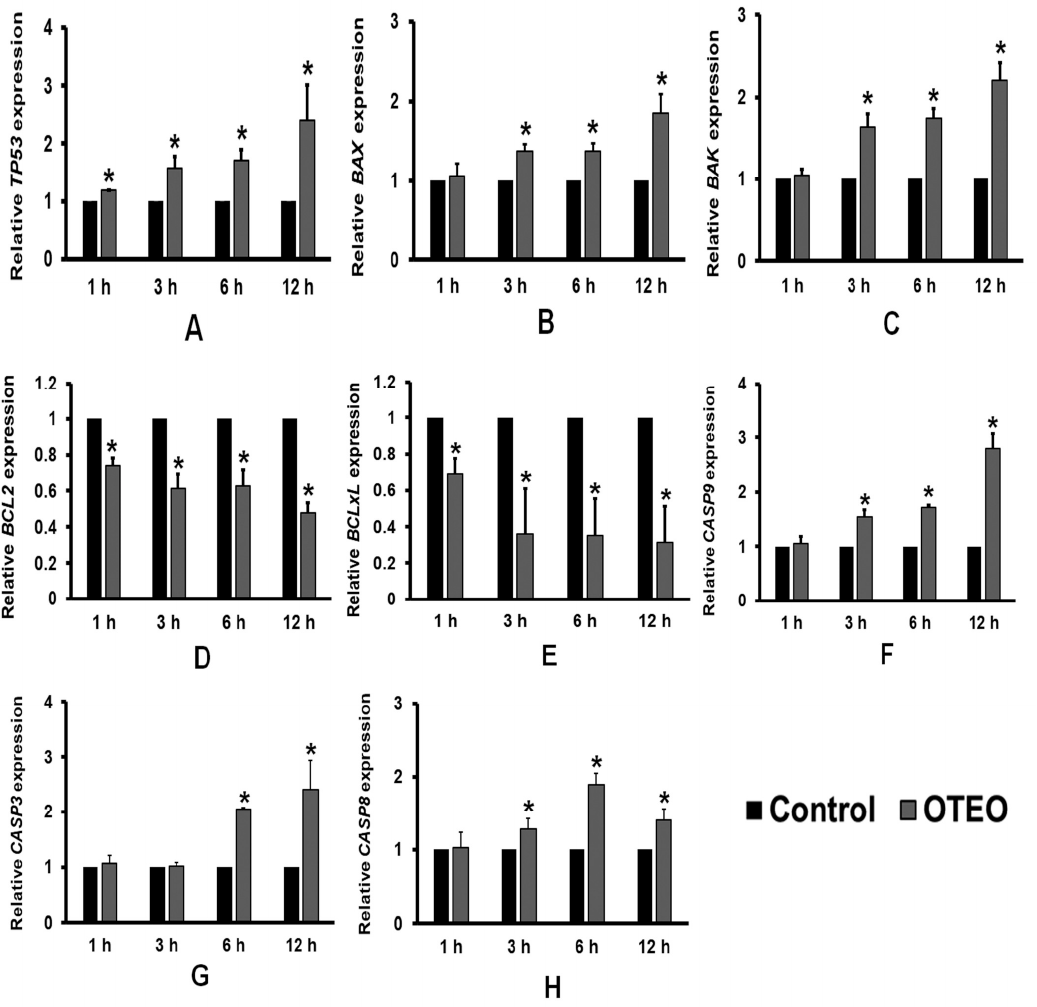
Figure 5. Effect of OTEO on the gene expression of ( A ) TP53 , ( B ) BAX , ( C ) BAK , ( D ) BCL-2 , ( E ) BCL-xL , ( F ) CASP9 , ( G ) CASP3 , and ( H ) CASP8 , in AGS treated cells, quantified by qRT-PCR. All data are presented as mean ± SD of the gene expression relative to an untreated control group, which were examined in triplicate independent experiments. * p < 0.05 indicates statistical significance versus control.